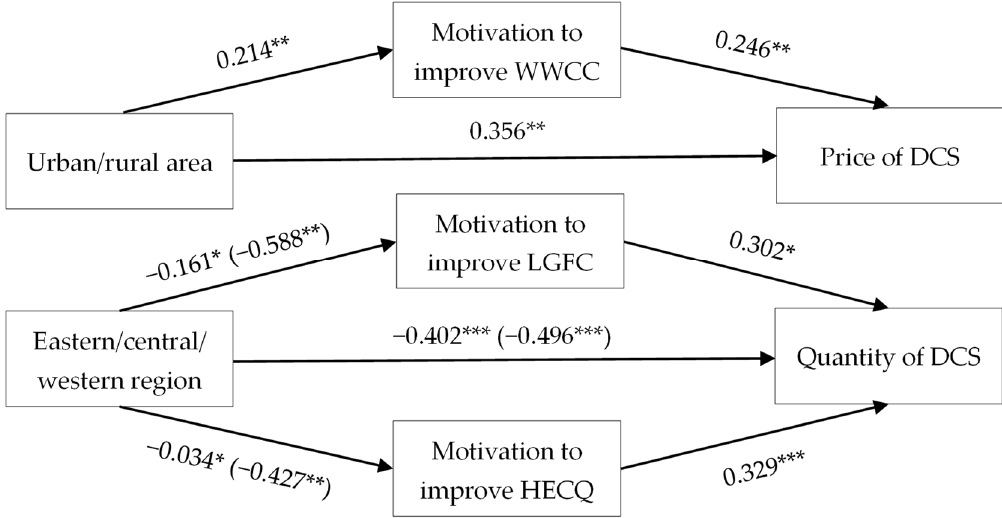
Figure 4. The mediating roadmap of FCC between RD and DCS. Note: * p < 0.1, ** p < 0.05, *** p < 0.01. The item inside parenthesis belongs to the western region, and the outside one belongs to the central region. Table 6. The mediating effect of motivation to improve FCC.